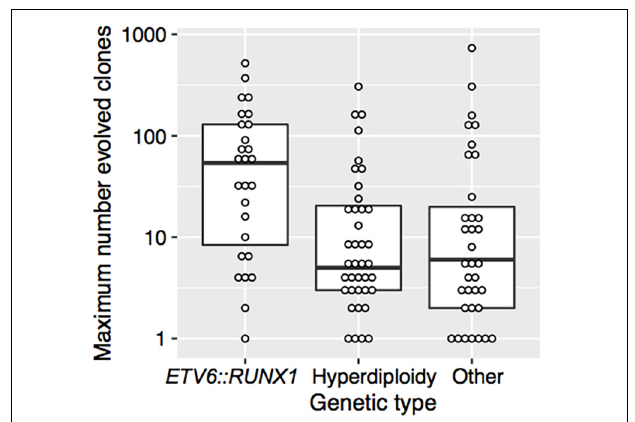
FIGURE 3 | The maximum number of evolved clones vs. genetic type. The thick horizontal lines represent the medians and the boxes indicate the first and the third quartiles of the maximum number of evolved clones. Each point shows data for one